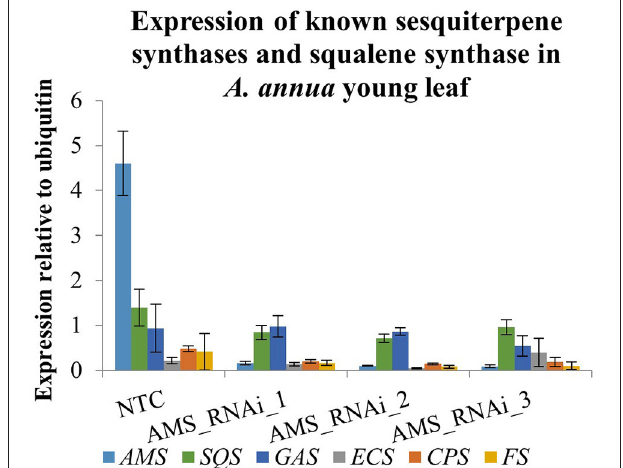
FIGURE 6 | Expression of functionally characterized sesquiterpene synthase ( AMS , GAS , ECS , CPS, and FS ) and SQUALENE SYNTHASE ( SQS ) genes in